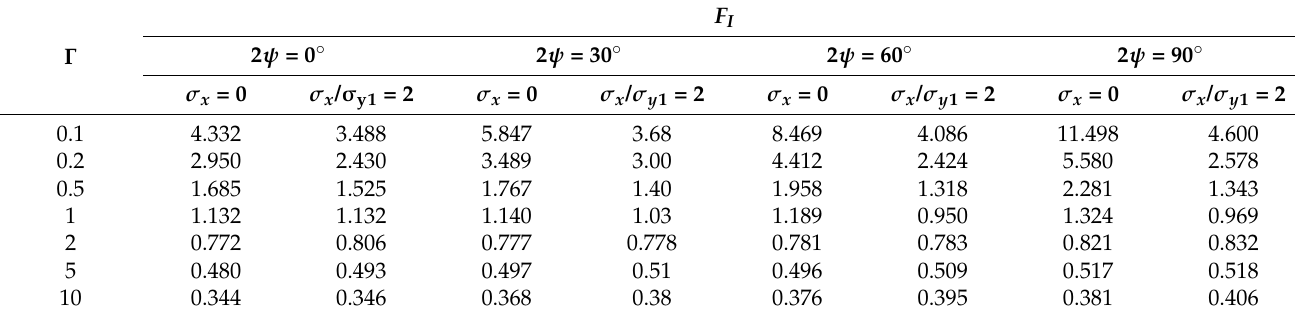
Table 4. Values of normalised stress intensity factors F I calculated for the rectangular plate with a double edge sharp corner under uniaxial/biaxial tension, a / w =